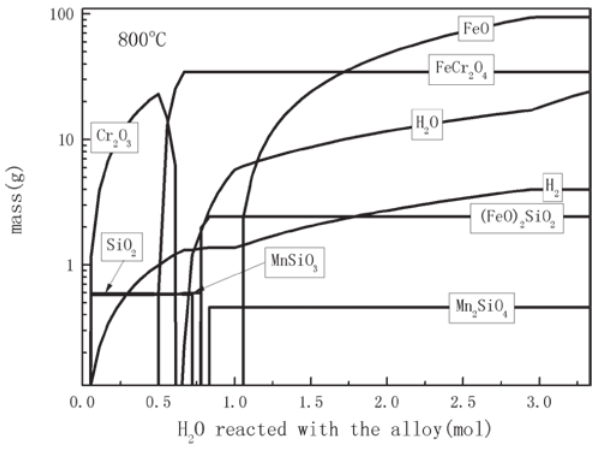
Fig. 4: Equilibrium of pure water vapor to 100 g Fe-16Cr alloy at 800 °C.